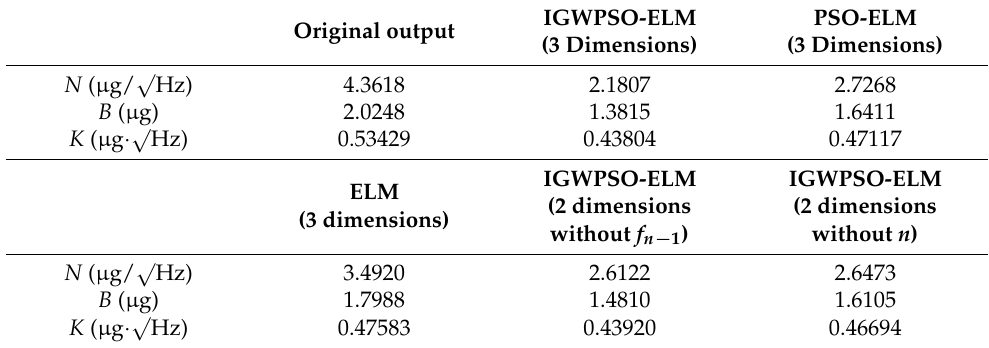
Table 3. Three random error coefficients of test data after compensated with different types of